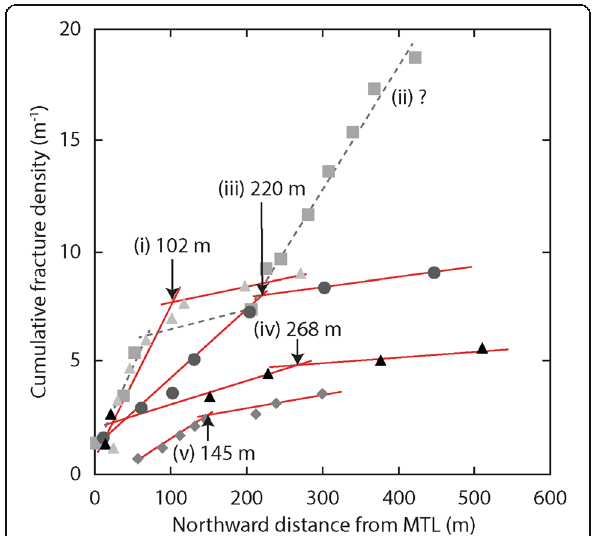
Fig. 4 Macrofracture densities measured within the Ryoke mylonites in the hanging wall of the MTL. Profile locations are indicated in Fig. 2a, b. The width of the damage zone associated with the MTL is estimated using the change in slope of cumulative fracture